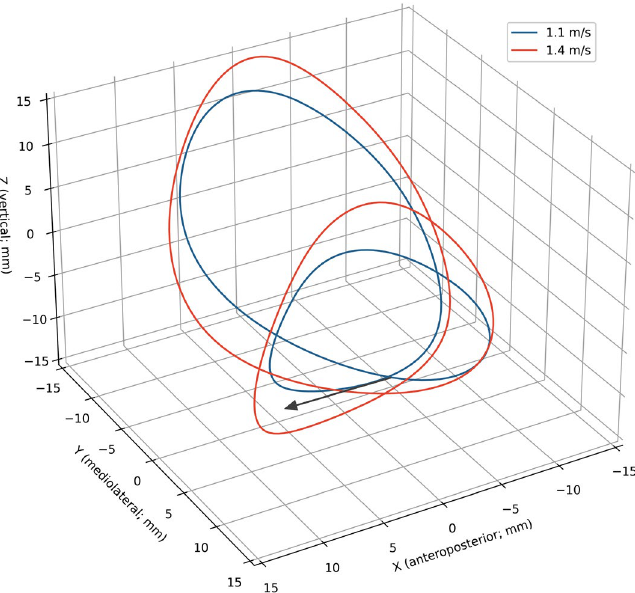
Figure 2. Mean three-dimensional trajectory of the BCoM at 1.1 and 1.4 m/s. The arrow indicates the walking progression direction. The trajectories form a closed loop since participants were walking on a treadmill; equivalent closed loops would have been obtained from ground walking by subtracting the displacement due to the average forward progression